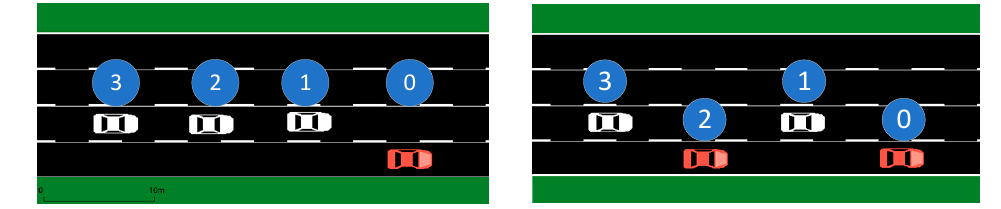
Figure 4. Result of traditional and proposed method.